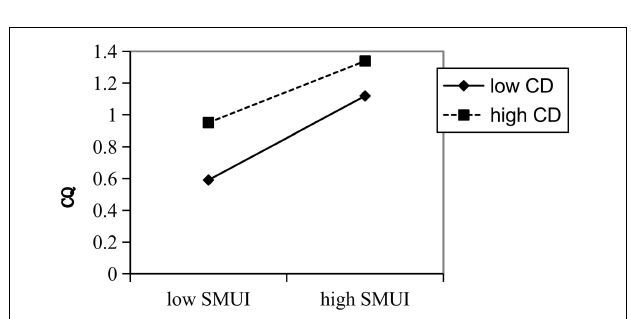
FIGURE 4 | Moderating effect of cultural distance on the relationship between socializing social media usage and cultural